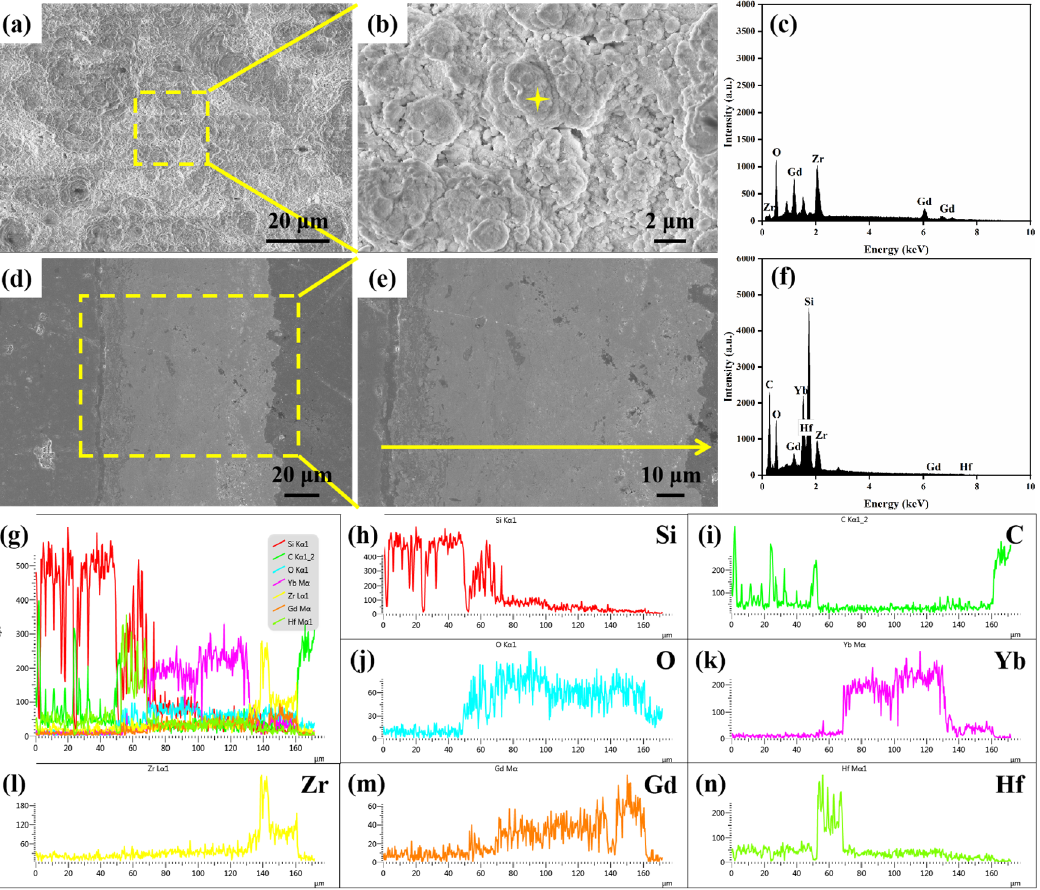
Figure 2. SEM images and EDS analysis of T/EBCs: ( a ) micromorphology of surface layer; ( b ) enlargement of ( a ); ( c ) point scan analysis; ( d ) micromorphology of cross-section; ( e ) enlargement of ( d ); ( f ) line scan analysis. Composition distribution of T/EBCS coatings cross section: ( g ) all elements; ( h ) Si; ( i ) C; ( j ) O; ( k ) Yb; ( l ) Zr; ( m ) Gd; ( n ) Hf.